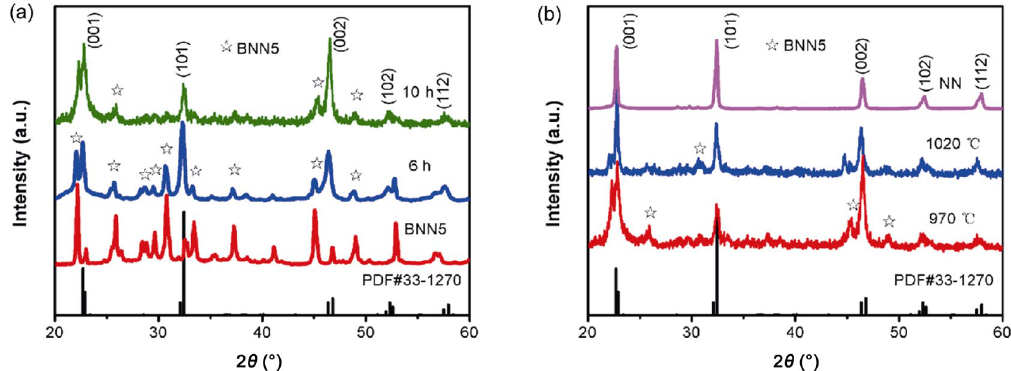
Fig. 4 XRD patterns of KNN platelets fabricated with different (a) sintering time and (b) sintering temperatures.